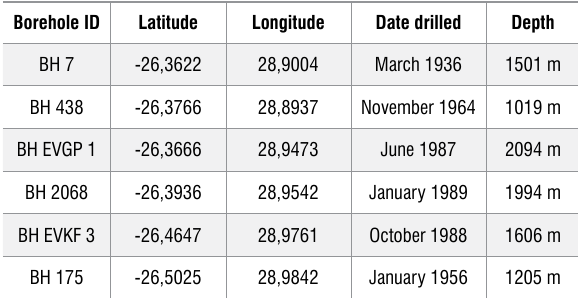
Figure 4: Schematic geological profile developed proximal to South Africa’s significant point-source CO Council for Geoscience Data Portal.